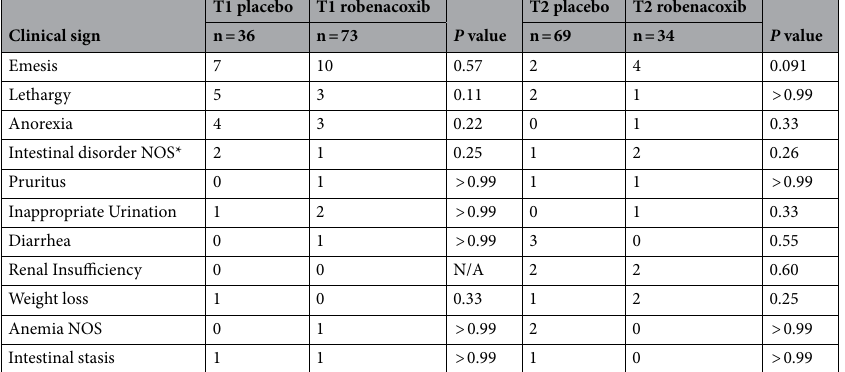
Table 8. Summary of the number of cats experiencing adverse events by clinical sign for both placebo and robenacoxib treatment. T1 treatment period 1, T2 treatment period 2, NOS not otherwise specified, n total number of cats receiving treatment in specified period. There were no significant differences in rates of adverse events occurrence between